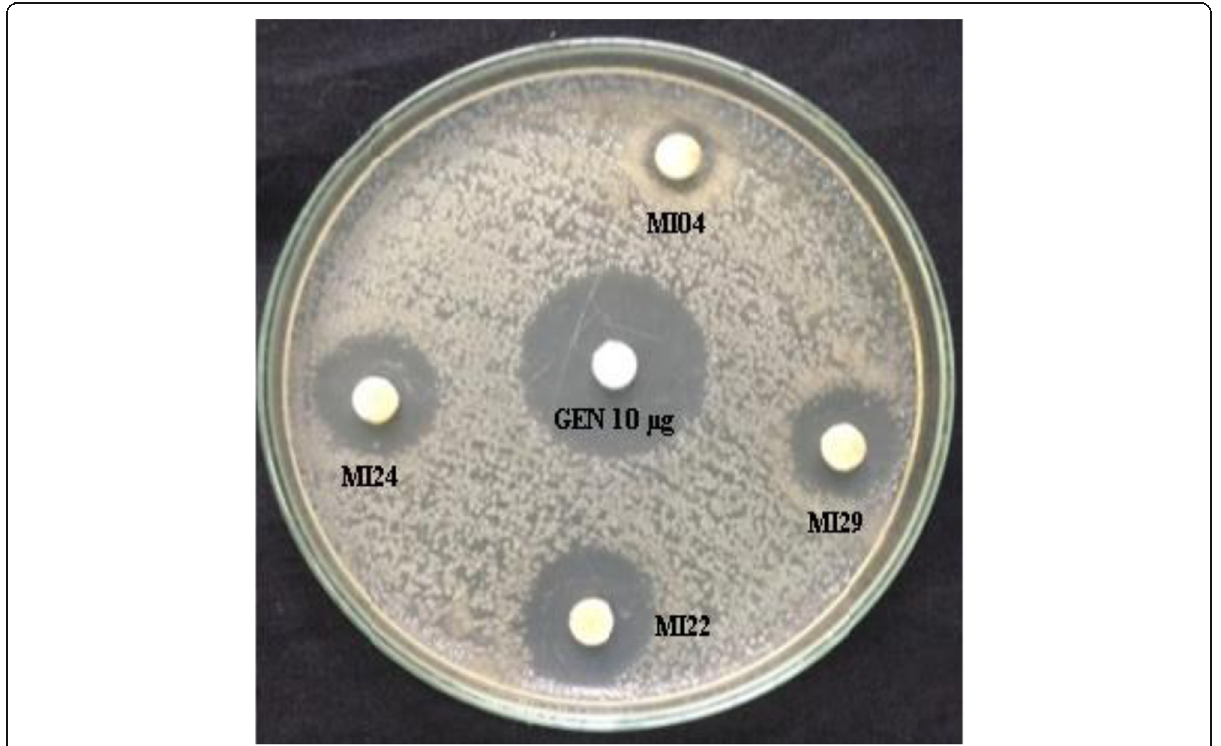
Fig. 4 Anti-microbial activity of ethyl acetate extract of Streptomyces strains against Methicillin-resistant Staphylococcus aureus by disc diffusion